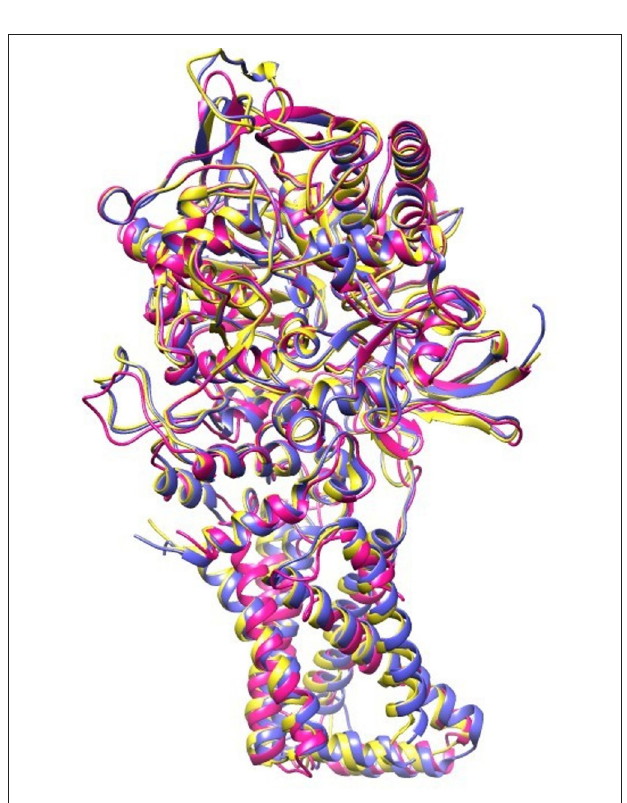
FIGURE 8 | Superimposed view of A. solani SDH model (pink) with 1YQ3 (blue) and 1ZOY